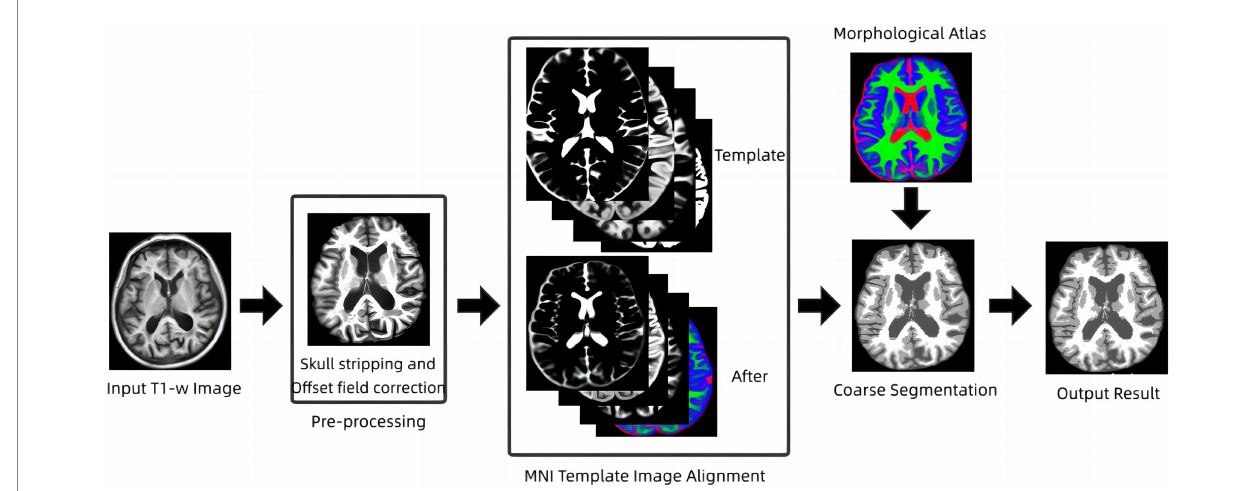
FIGURE 1 Flowchart of energy minimization algorithm based on anatomical mapping.